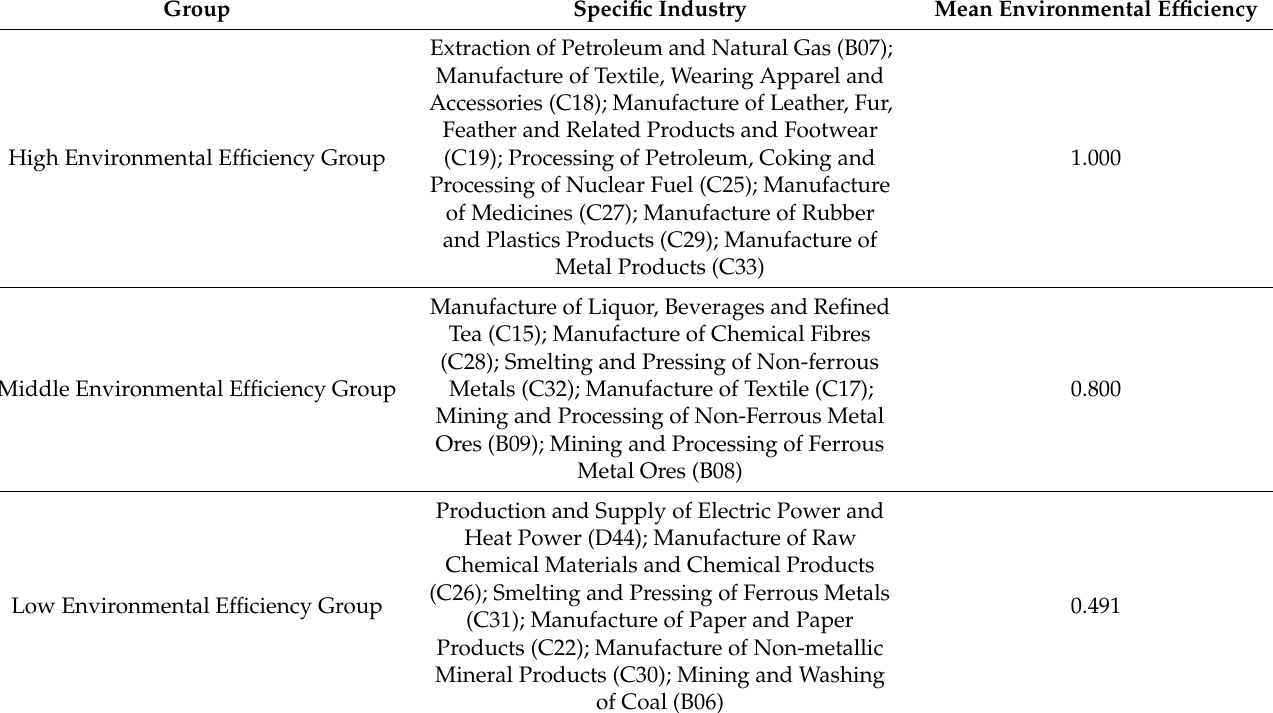
Figure 2. The average environmental efficiency of high-polluting sub-industries. Table 4. Grouping of high-pollution sub-industries in